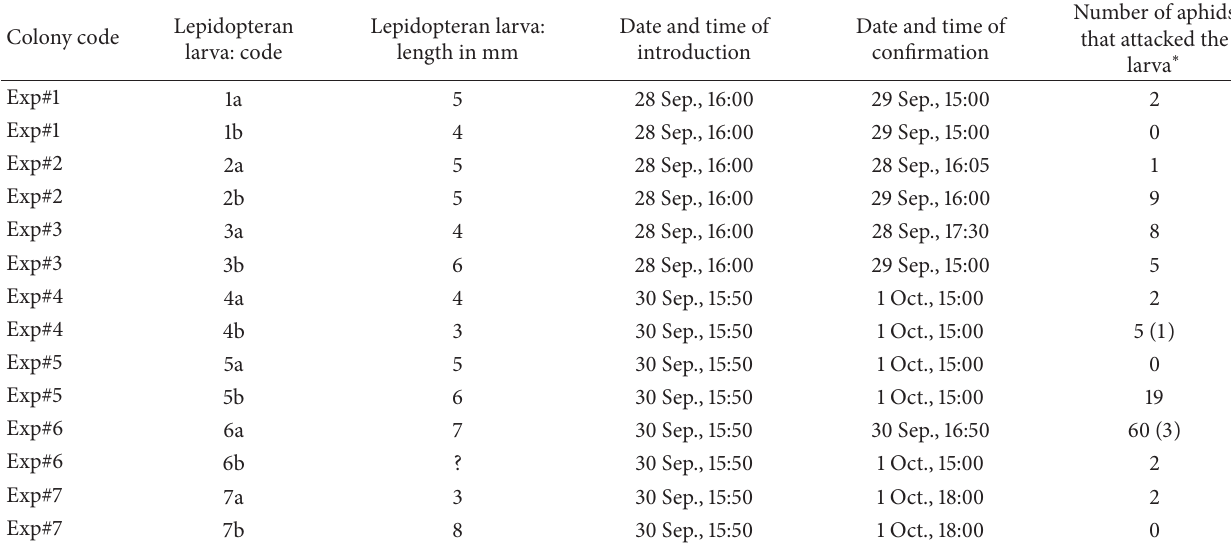
Table 3: Results of introducing lepidopteran larvae onto seven colonies.